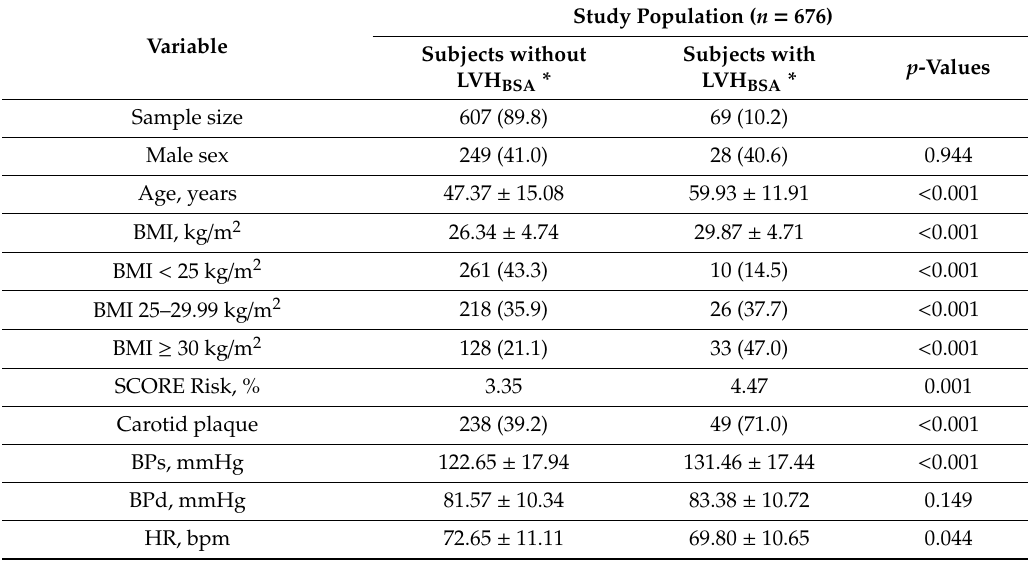
Table 3. Clinical, biochemical, electrocardiographic, echocardiographic, and body composition characteristics compared between individuals with and without left ventricular hypertrophy using echocardiography (ECHO) in the general